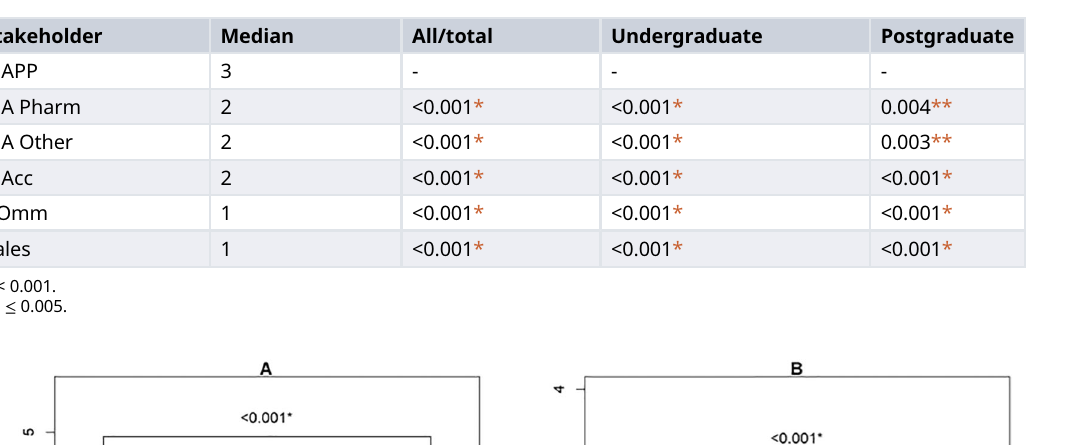
Table 4. Difference in number of degree qualifications between MAPPs and other internal